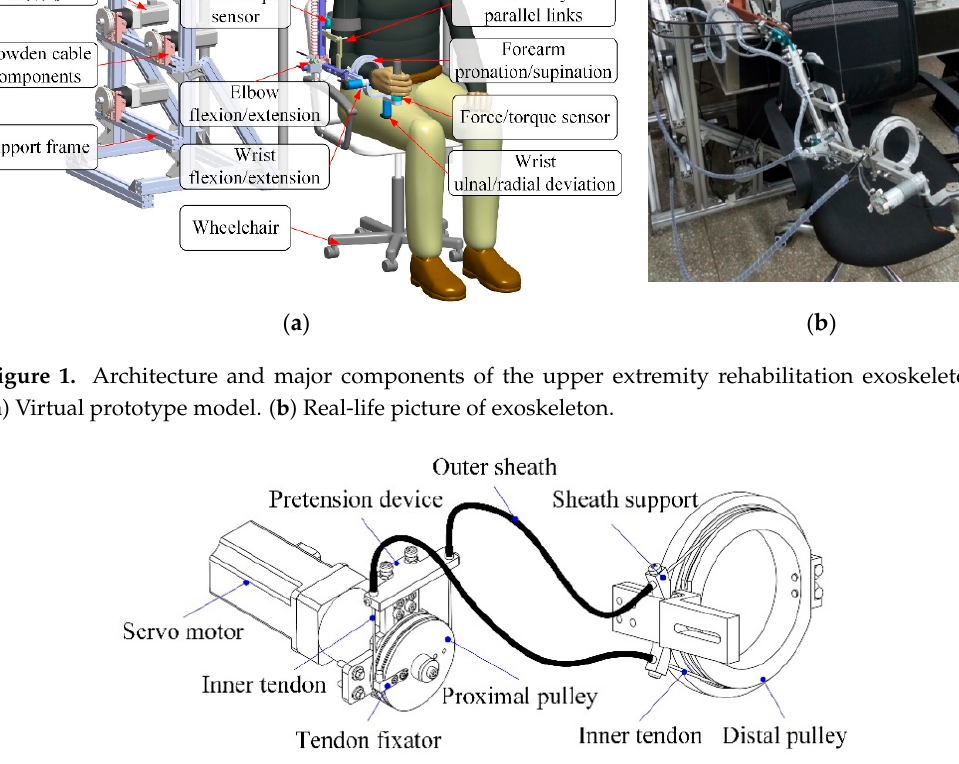
Figure 2. Schematic of the flexible double-tendon-sheath transmission system.